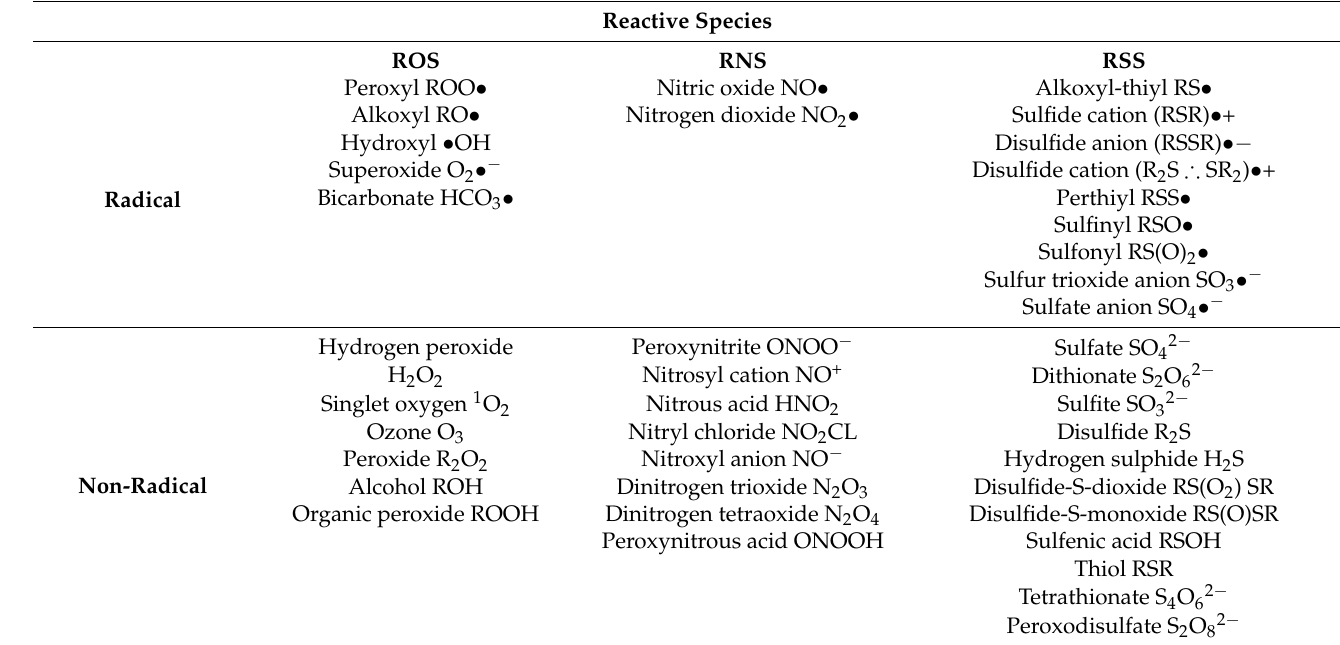
Table 1. Reactive oxygen (ROS), nitrogen (RNS), and sulfur (RSS) species and their non-free- radical species. Reactive